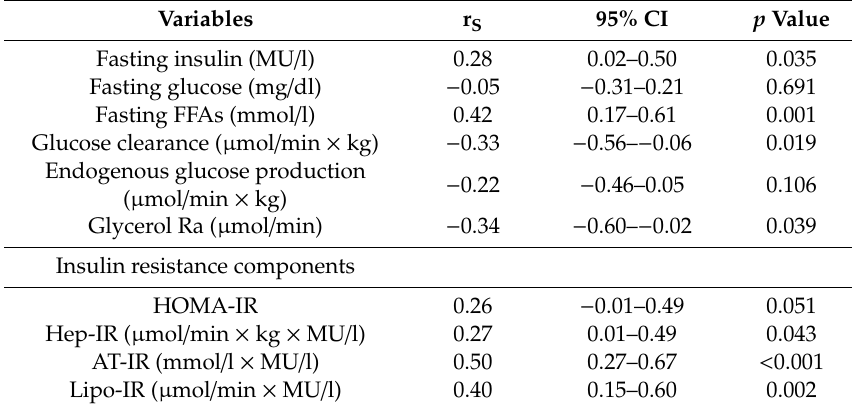
Table 2. Correlation between selenoprotein P levels and biochemical and metabolic parameters as well as insulin resistance